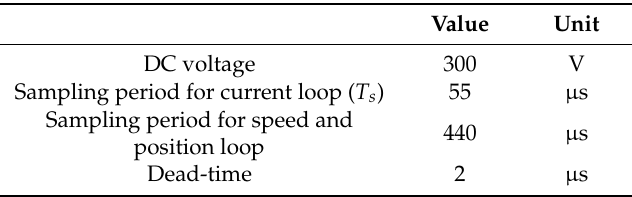
Table A1. Main drive parameters.